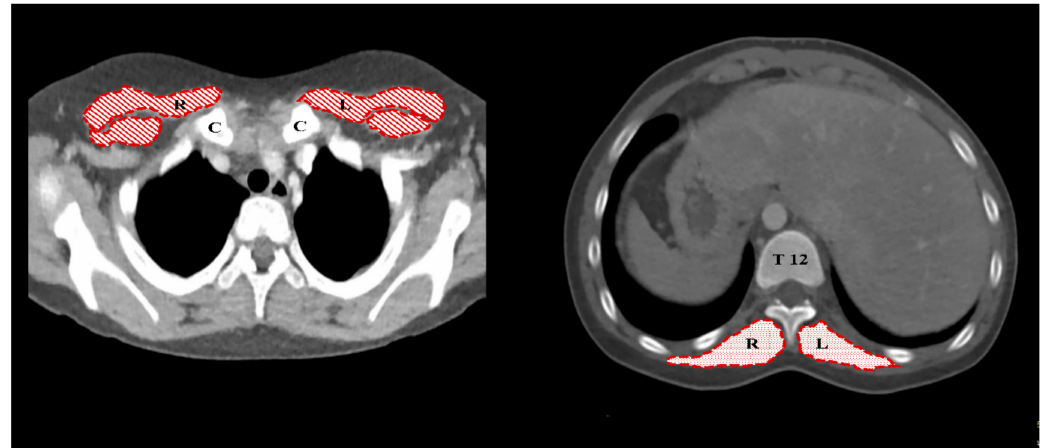
Figure 1. Axial computed tomography (CT) image for the cross-sectional area measurements of pectoralis and erector spinae muscles. The areas shaded with oblique lines are the pectoralis muscles (left), and the areas shaded with dots are the erector spinae muscles (right). R, right; L, left; C, clavicle; T12, 12th thoracic